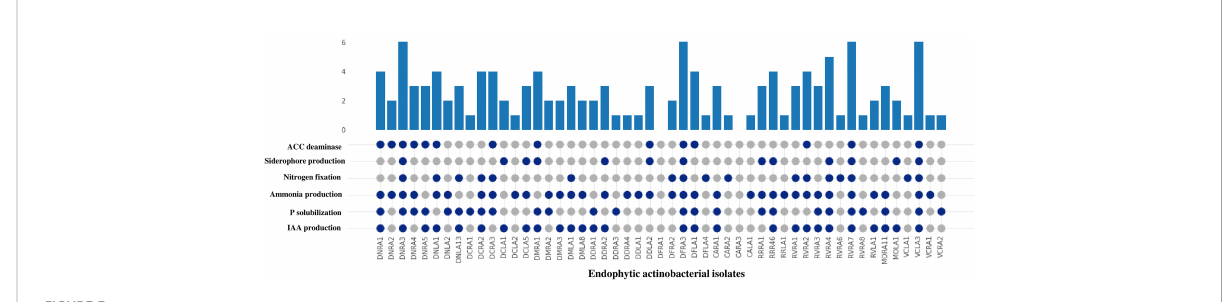
FIGURE 3 Comparison of PGP traits (IAA production, P (phosphate) solubilization, ammonia production, nitrogen fi xation, siderophore production and ACC deaminase) among 51 endophytic actinobacterial isolates. The bar value represents the total no of PGP traits shown by the isolates. The presence and absence of PGP traits are represented by the blue and gray circles, respectively. 49 isolates exhibited presence of at least one PGP traits except isolates DFRA1 and CARA3. Isolates DNRA3, DFRA3, RVRA7 and VCLA3 showed the presence of all the PGP traits.